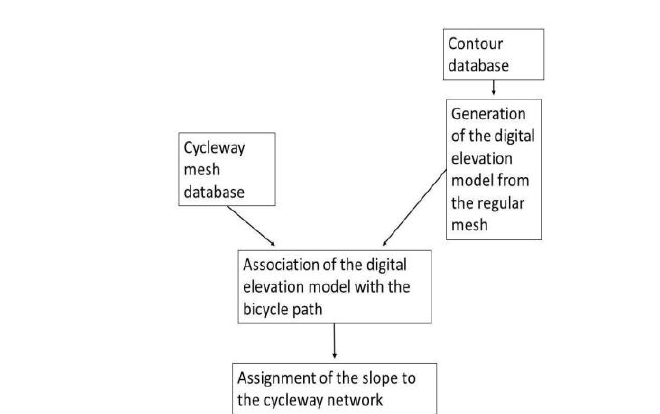
Figure 3: Activity flow chart Fonte: The